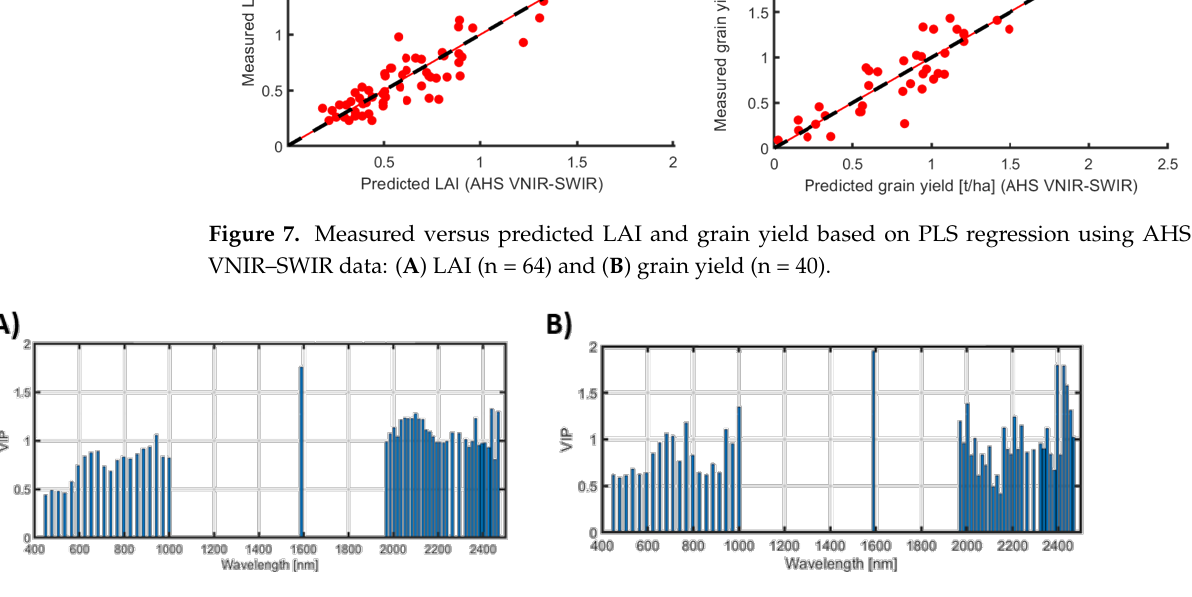
Figure 8. Variable importance in projection (VIP) of AHS spectral bands obtained by PLS regression for ( A ) LAI and ( B ) grain yield estimation.